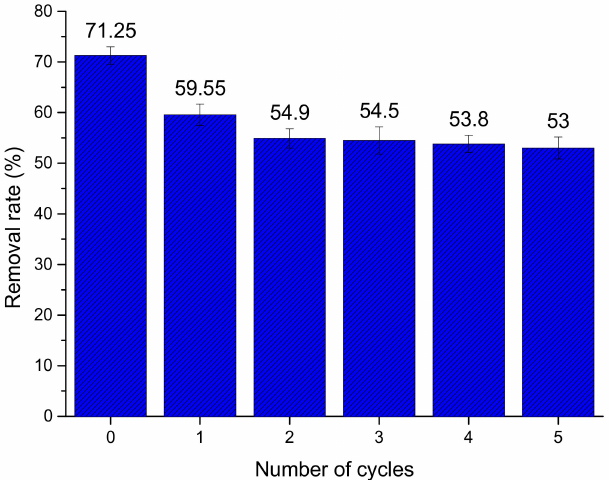
Figure 9. Removal rates of HBP- g -BC after different cycles of